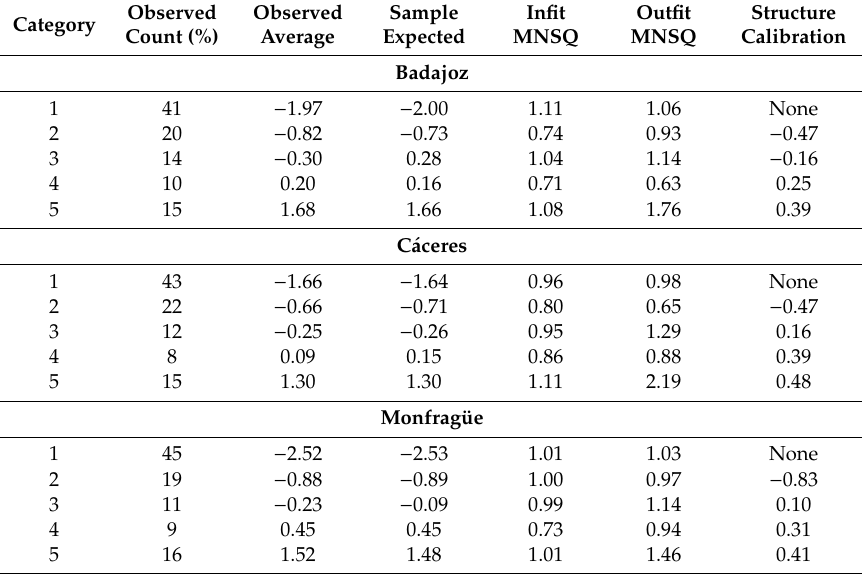
Table 3. Response scale use: number of times the category was selected considering all days and items, pollutants and climatic factors (observed count), mean value of logit positions modelled in the category (observed average), optimum values of the average logit positions for the data (sample expected), and logit calibrated di ffi culty of the step representing the transition points between one category and the next (structure calibration). Infit and outfit MNSQ are mean-square fit statistics to verify if items fit the